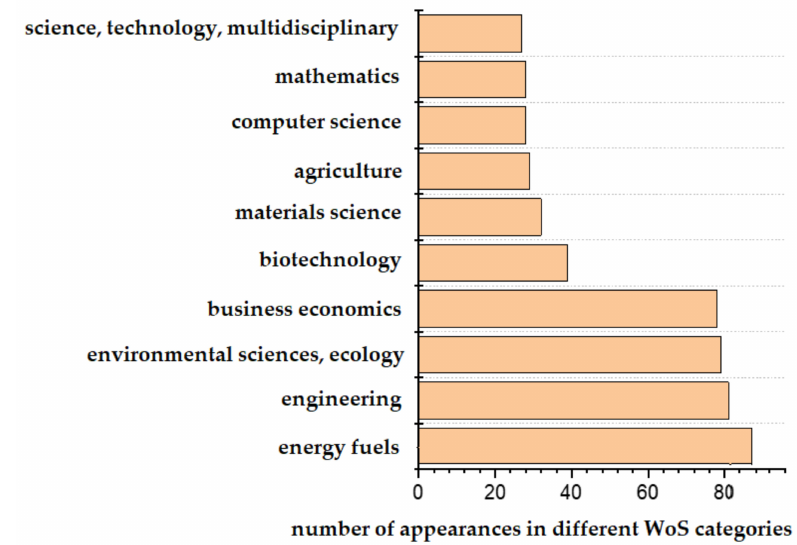
Figure 1. Number of articles concerning biofuel and system dynamics in Web of Science publications, appearing in di ff erent WoS categories (source: own research,